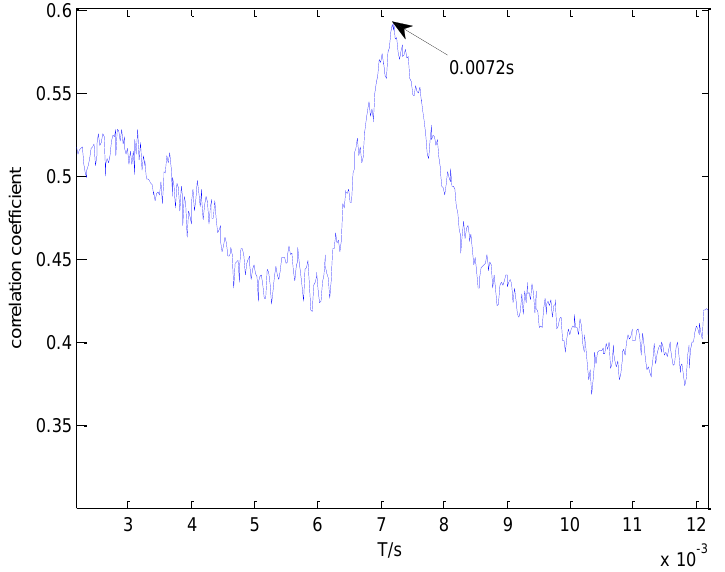
Figure 11. Maximal correlation coefficients for different elements from set T .